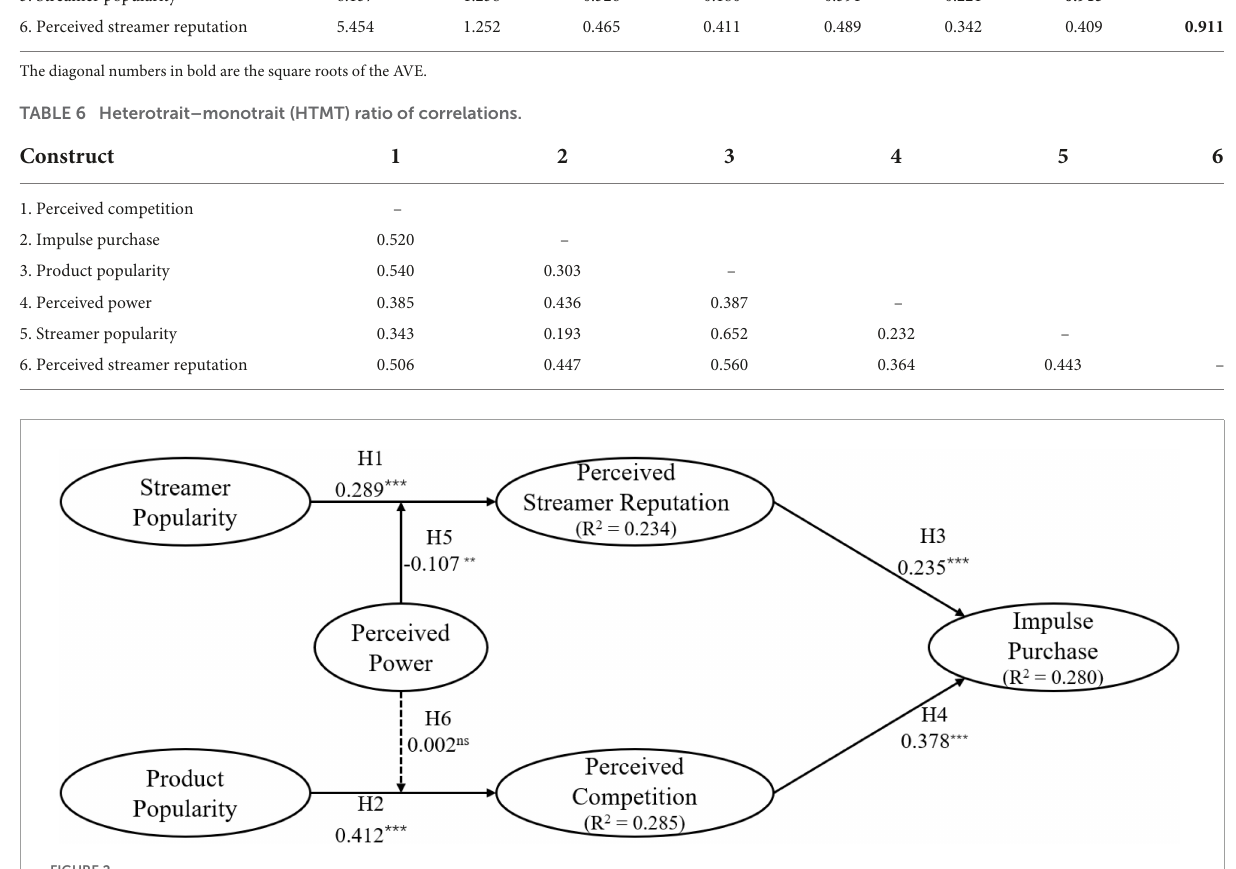
FIGURE2 Hypothesis test results. ** p < 0.01, *** p < 0.001, ns, no significant at the 5% significance level.